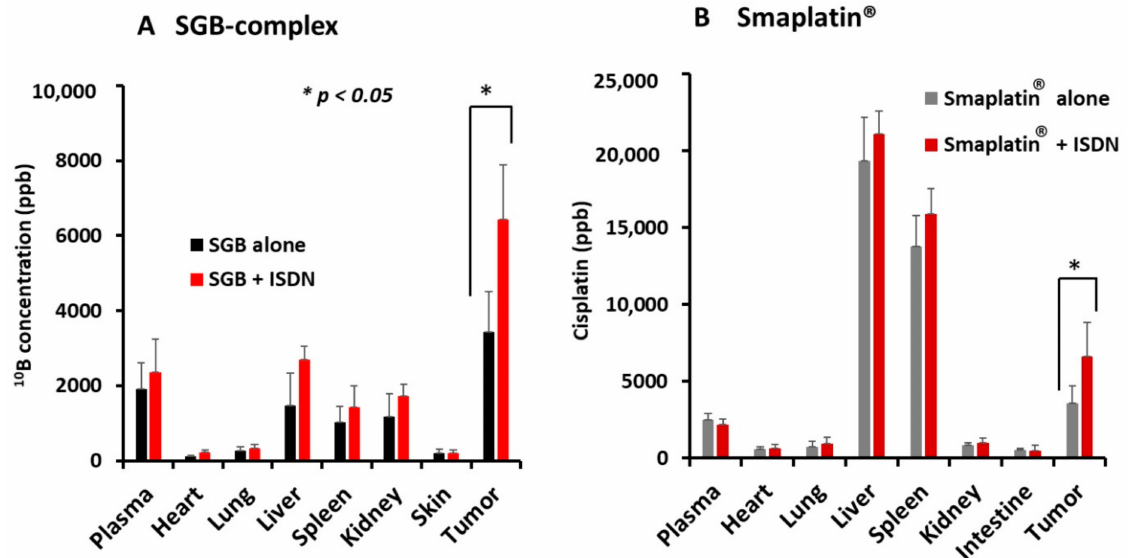
Figure 2. ISDN-enhanced accumulation of SGB-complex ( A ) and Smaplatin ® ( B ) in C26 tumor tissues. SGB-complex at 15 mg/kg (boric acid equivalent) or Smaplatin at 10 mg/kg (Cisplatin equivalent) was administered iv; 30 mg/kg ISDN was administered ip as an EPR-effect enhancer. At 24 h after drug treatment, the amounts of 10 B and platinum in tissues were quantified by means of ICP-MS according to the manufacturer’s procedure. Data are expressed as means ± SD. ( n = 5 ) See text for